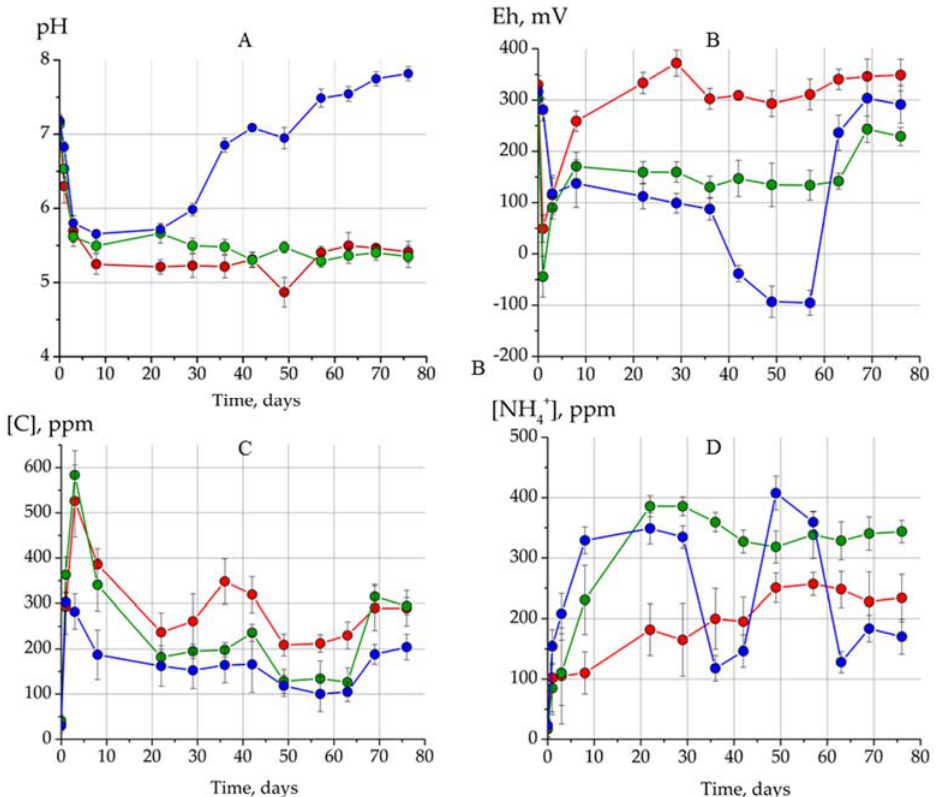
Figure 4. The main metabolic parameters of P. stratiotes L. plant fermentation: pH ( A ); Eh ( B ); concentration of total carbon ( C ); concentration of ammonium ions ( D ). The graph shows the dynamics of changes in metabolic parameters in control conditions without GMP (red lines), in the presence of GMP1 based on hydrogen-synthesizing microorganisms (green lines), and in the presence of GMP2 based on methane-synthesizing microorganisms (blue lines).